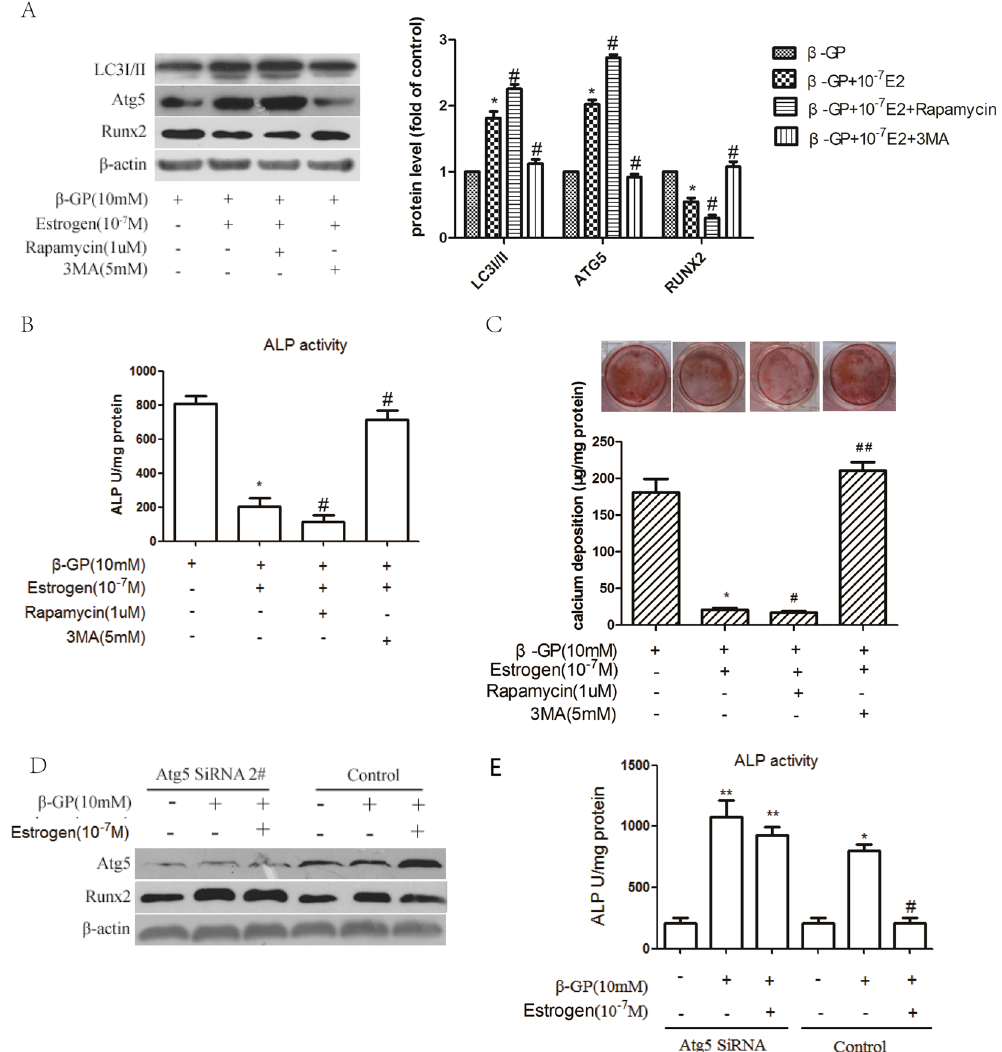
Figure 5. Oestrogen inhibits the calcification of VSMCs via promotion of autophagy. ( A , B ) VSMCs were pre- treated with the indicated concentrations of 3MA or rapamycin for 30 min and subsequently incubated with medium containing β -GP and oestrogen for 72 h. LC3I/II, Atg5 and Runx2 levels ( A ) and ALP activity ( B ) were detected using Western blot analysis or an ALP kit, respectively. * p < 0.01 compared with the cells treated with β -GP. # p < 0.01 compared with the cells treated with β -GP and oestrogen (n = 5). ( C ) VSMCs were pre- treated with the indicated concentrations of 3MA or rapamycin for 30 min and then incubated with β -GP and oestrogen for 12 days. A representative plate view of the Alizarin Red S staining is shown. Quantification of calcium levels using the O-cresolphthalein complexone method. * p < 0.01 compared with the cells treated with β -GP. # p < 0.05 and ## p < 0.01 compared with the cells treated with β -GP and oestrogen (n = 5). ( D , E ) VSMCs were transfected with control or Atg5 2# siRNA for 48 h and treated with or without β -GP and oestrogen for 72 h. Western blot analysis of Atg5 and Runx2 protein levels ( D ) and ALP activity detection ( E ) were performed. * p < 0.01 compared with the cells treated with vehicle in the control group and # p < 0.01 compared with the cells treated with β -GP in the control group. ** p < 0.01 compared with the cells treated with vehicle in the ATG5 siRNA group (n = 5). Representative images are